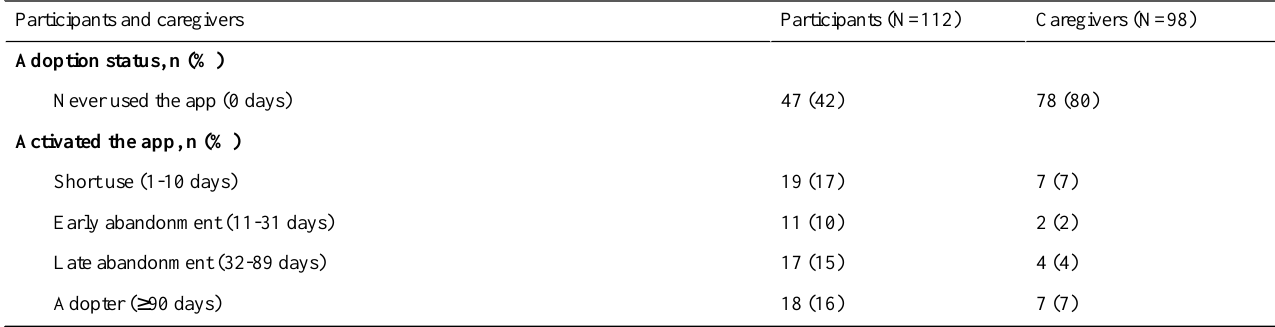
Table 2. Adoption status and period of adherence among participants and caregivers.